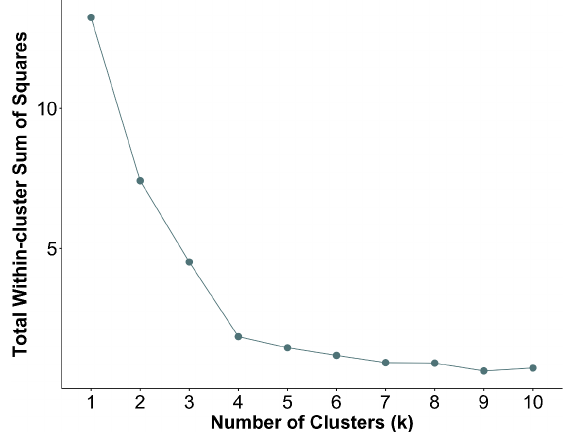
FIG. 9. Elbow plot for the k -means cluster analysis using the data transformed with the fourth root function. Maximizing the proportion of total sum of squares explained by the between- cluster sum of squares informed our choice to perform cluster analysis with k ¼ 4 .